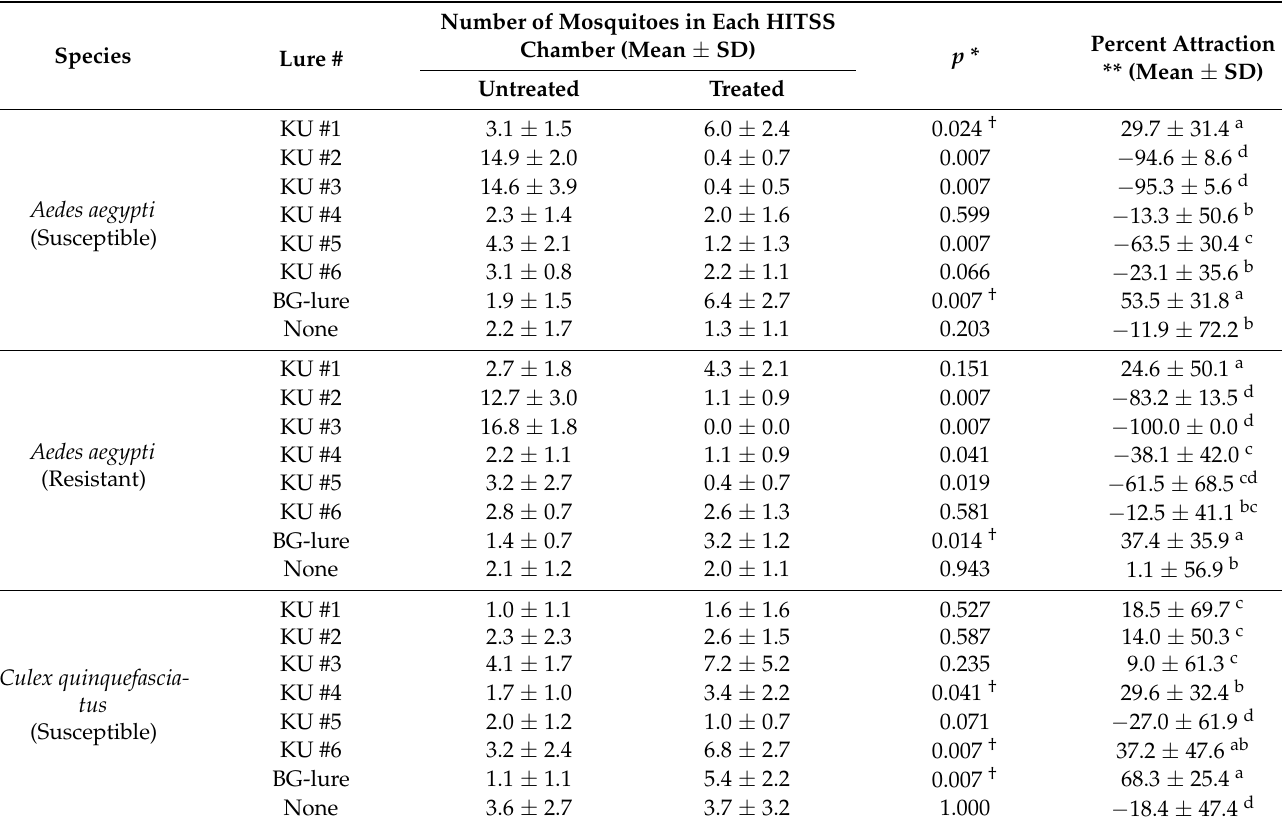
Table 3. Mean number of mosquitoes attracted or repelled by the